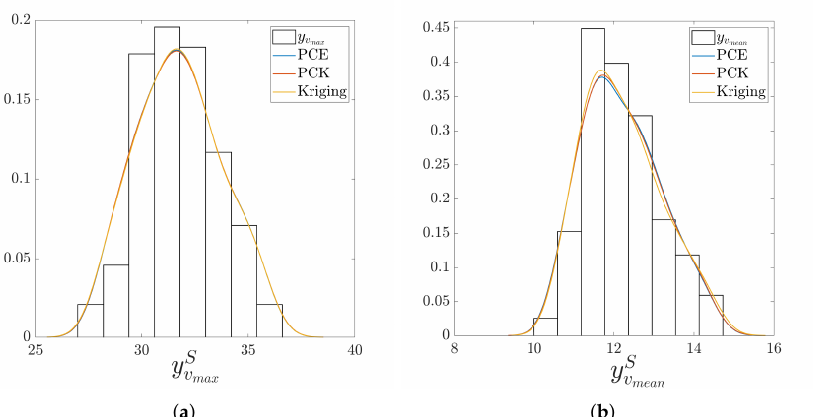
Figure 10. Comparison between histogram measurements and corresponding surrogate estimates for ( a ) v max and ( b ) v mean .